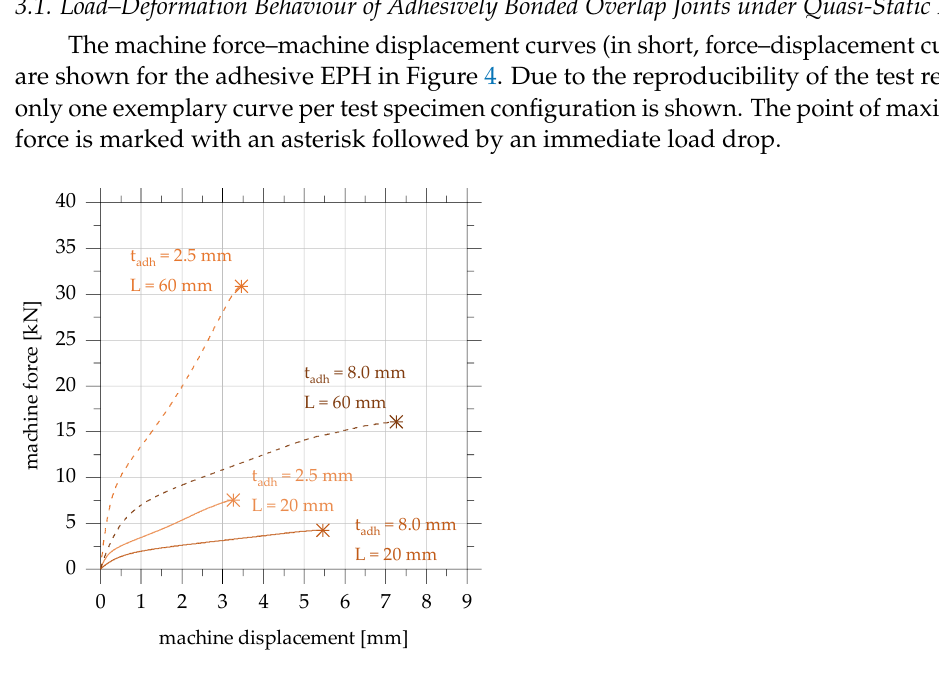
Figure 4. Machine force–machine displacement diagram of quasi-static tensile tests on overlap joints in accordance with [22].